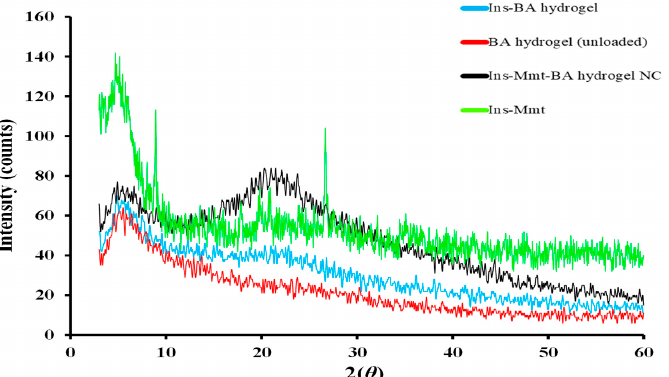
Figure 7. Overlay of X-ray diffractograms of unloaded BA hydrogel, Ins-BA hydrogel, Ins-Mmt-BA hydrogel NCs and Ins-Mmt clay. 3.10. Thermal Studies/Differential Scanning Calorimetry (DSC) and Thermogravimetric Analysis (TGA) Thermal changes such as enthalpy changes and phase transition temperature of un- loaded BA hydrogel and thermal stability of BA hydrogel versus Ins-Mmt-BA hydrogel NCs were assessed by DSC and TGA studies.